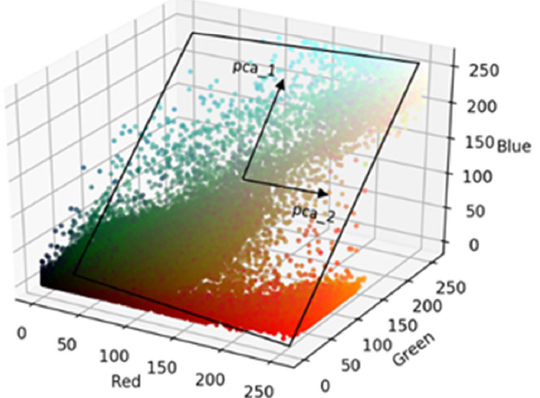
Figure 8. Illustration of a plane spanned by the first two principal component vectors of a color-point- distribution in 3D RGB-Space, based on